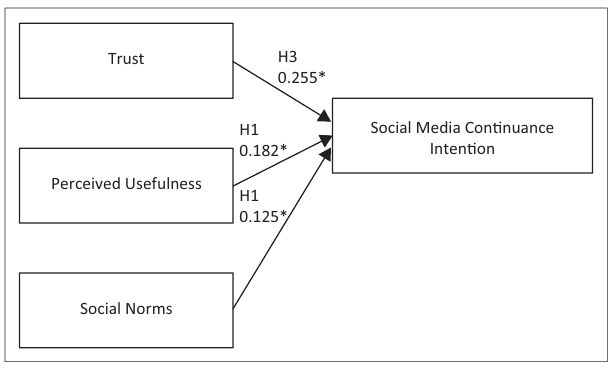
FIGURE 2: Regression model results.